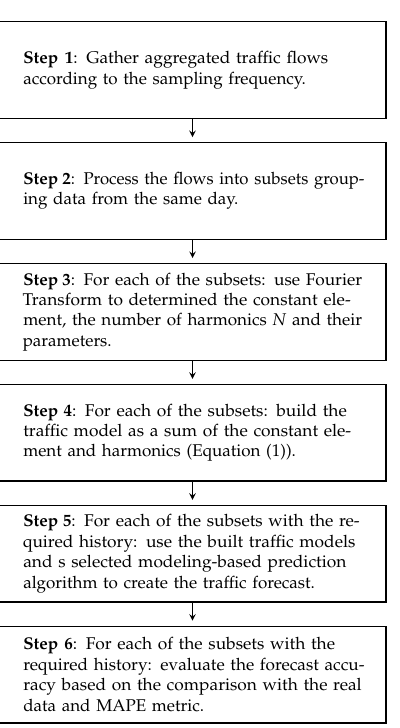
Figure 8. Modeling-based traffic prediction—the